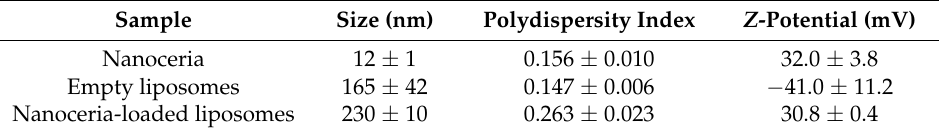
Table 1. Characterization of nanoceria, liposomes, and nanoceria-loaded liposomes dispersions.